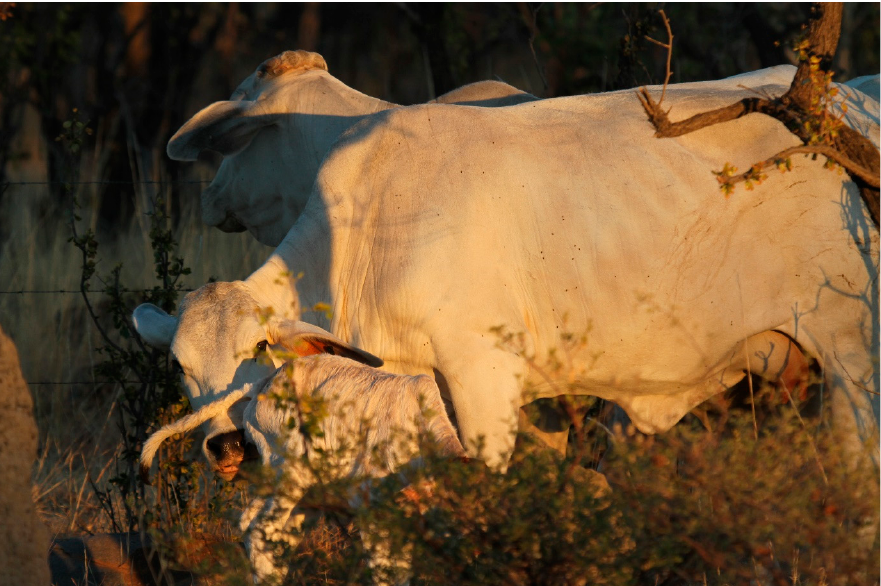
Figure 1. Example of typical postpartum behavior exhibited by a Bos indicus beef cow shortly after parturition. A matriarchal herdmate who is about to deliver her own calf stands close-by on high alert .